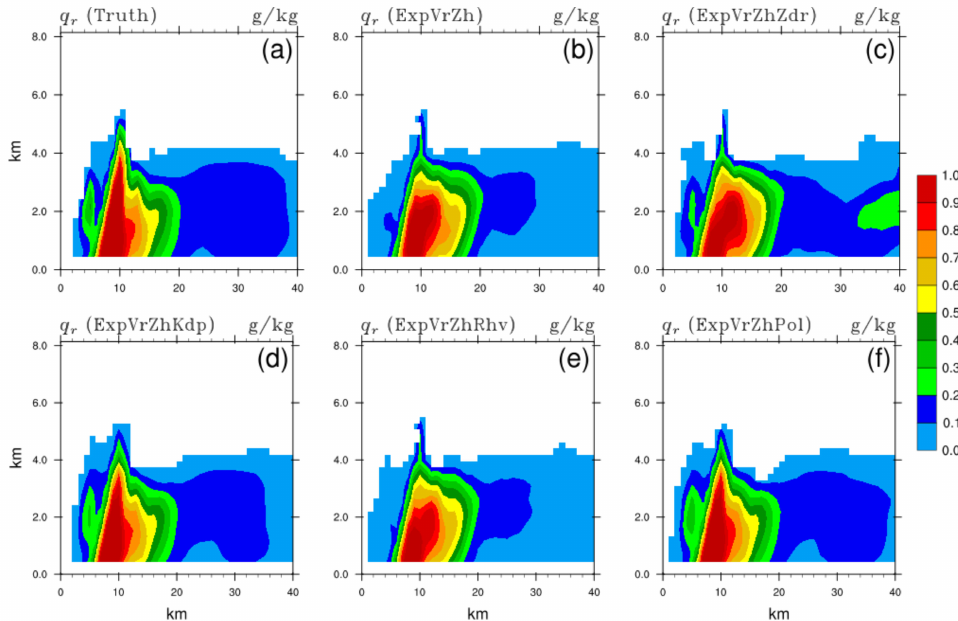
Figure 12. The same as Figure 7, but for the mixing ratio of rain water q r (unit: g/kg) of ( a ) truth, and analysis fields of ( b ) ExpVrZh, ( c ) ExpVrZhZdr, ( d ) ExpVrZhKdp, ( e ) ExpVrZhRhv, and ( f ) ExpVrZhPol, respectively.